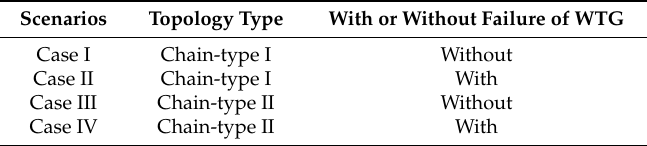
Table 5. Four scenarios for reliability analysis of wind farm electrical topology.